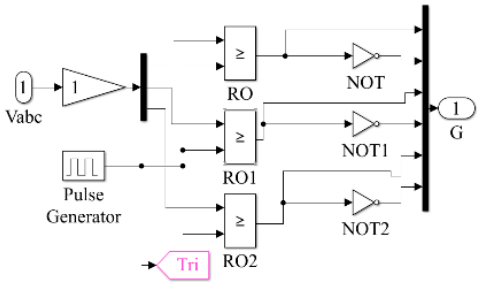
Figure 14. PWM signal output model.